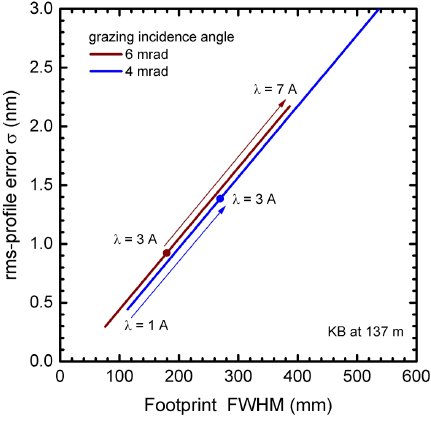
Figure 7. Required surface quality of the Kirkpatrick-Baez (KB)